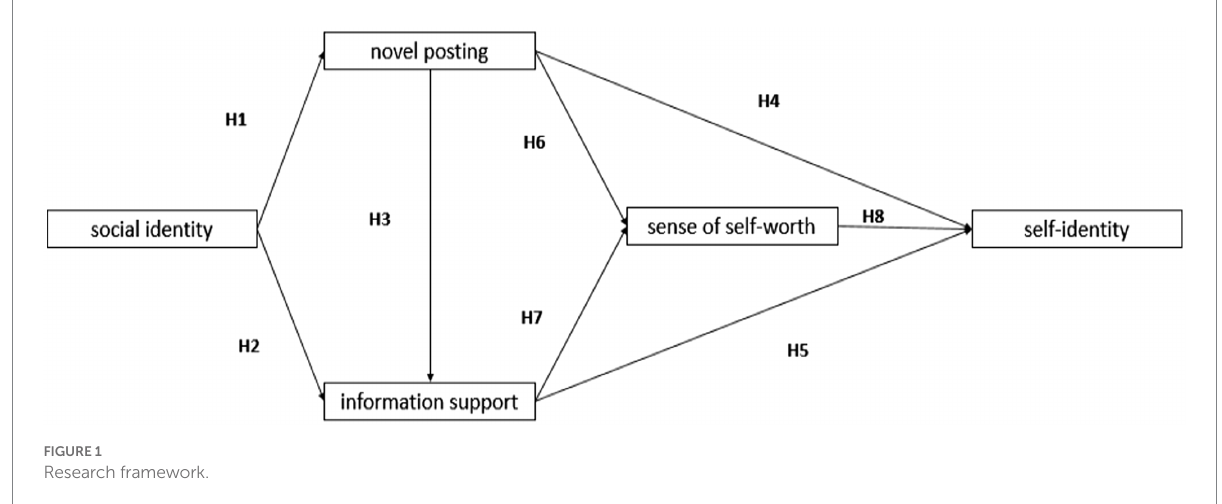
FIGURE 1 Research